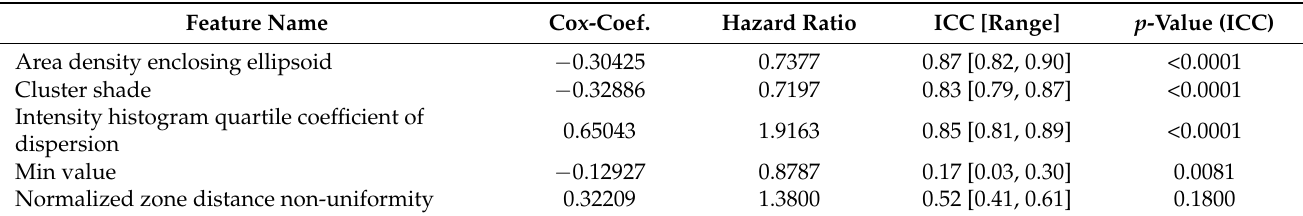
Table 1. Features included in the final Cox proportional-hazards model with their respective co- efficients, hazard ratios, and ICCs computed by comparing the values in Med-CT with those in Par-CT.